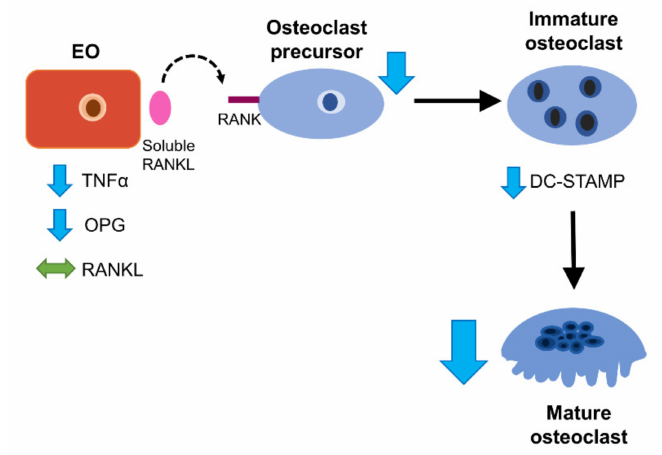
Figure 10. EO-Derived Factors Reduce Osteoclastogenesis. EO cells secrete soluble RANKL, which binds to the RANK receptor on osteoclast progenitor cells to initiate osteoclast differentiation. We found that EOs have decreased expression of osteoclastogenic factors OPG soluble protein and TNF α soluble protein. When determining the affect EO cells have on osteoclastogenesis, we found that osteoclasts exposed to EO-derived factors or produced in the presence of EO cells were less in number and smaller in size. When examining osteoclast fusion, we found that osteoclasts exposed to EO-derived factors have decreased expression of osteoclast-fusion protein DC-STAMP. Further- more, osteoclasts produced in the presence of EO cells have decreased resorptive activity. Overall, the presence of EO cells decreases osteoclast formation and resorption, reducing